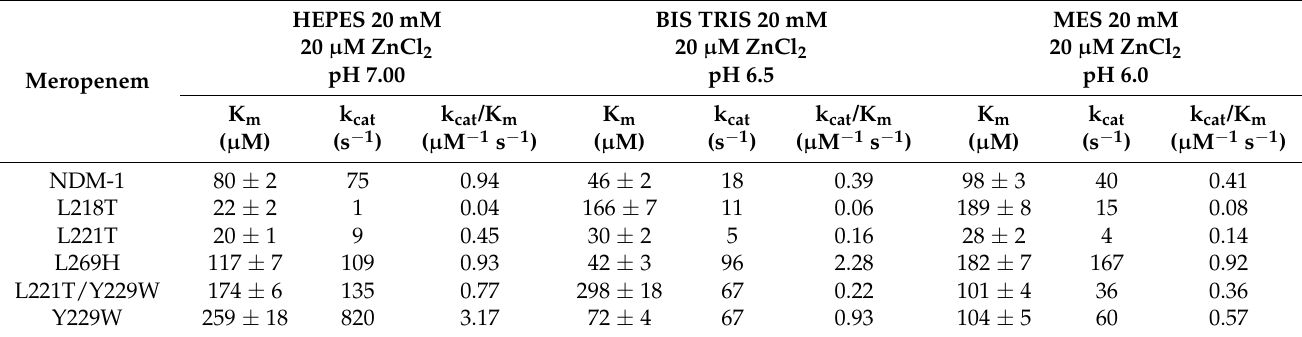
Table 2. Effect of pH on K m , k cat and k cat /K m of meropenem for L218T, L221T, L269H, Y229W and